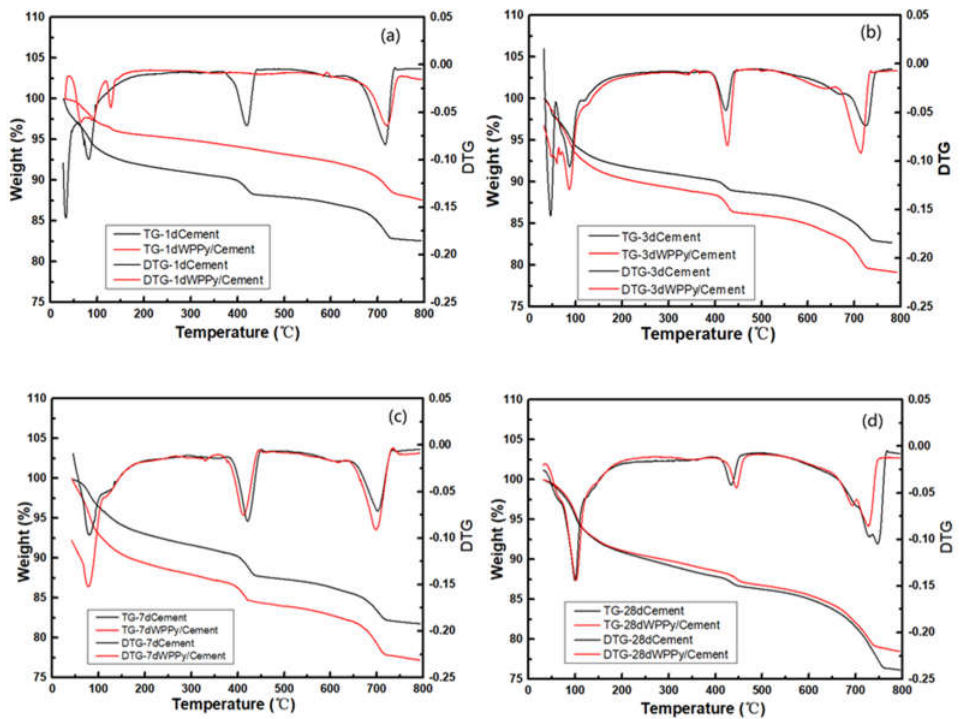
Figure 7. TGA and DTG curves of cement paste and WPPy/cement composites with different hydration ages. 1 day ( a ), 3 days ( b ), 7 days ( c ), 28 days ( d ).